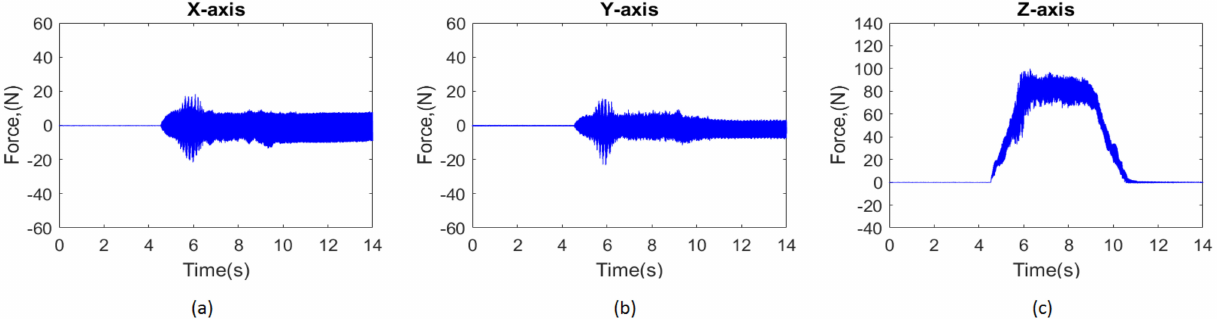
Figure 2. Typical time histories of cutting forces ( Fx , Fy, and Fz ) measured in the drilling process. ( a ) X -direction, ( b ) Y -direction, ( c ) Z